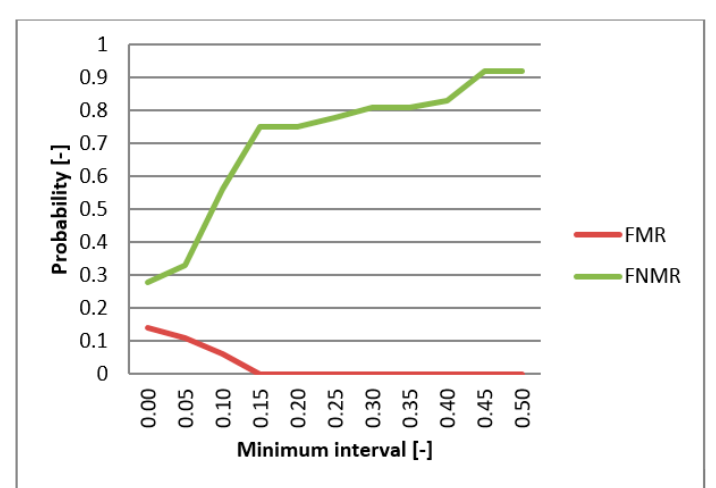
Figure 14. EER for Euclidean distance.